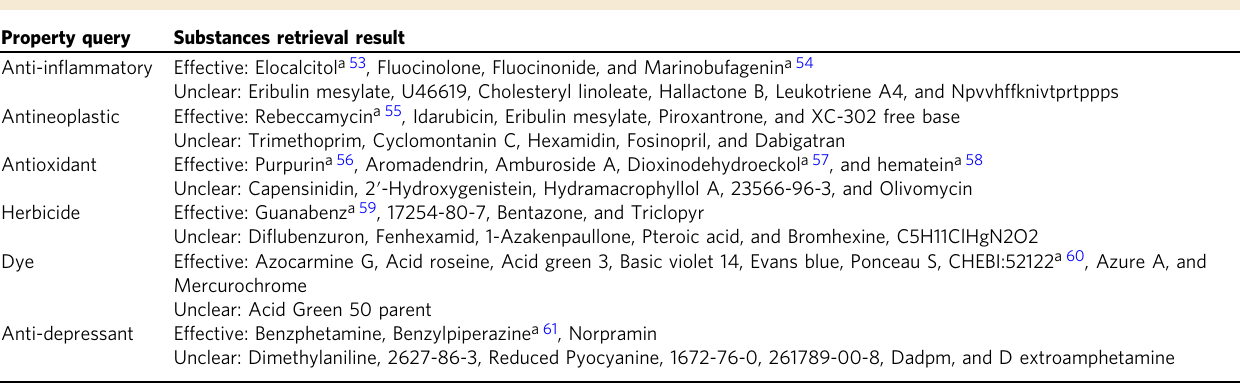
Fig. 5 Case study for property prediction. The molecular structures are fi rst serialized in SMILES strings. With more SMILES sub-groups provided (in purple), the model can predict the properties more precisely. Table 2 Case study for drug